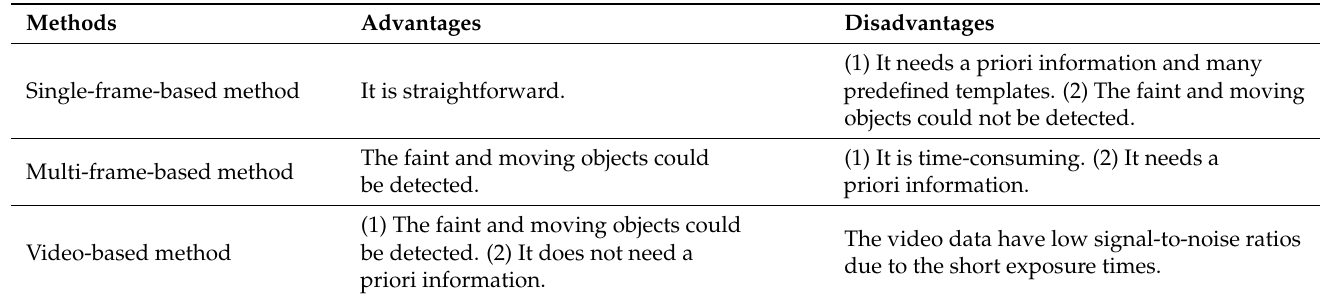
Table 2. The advantages and disadvantages of different space debris detection